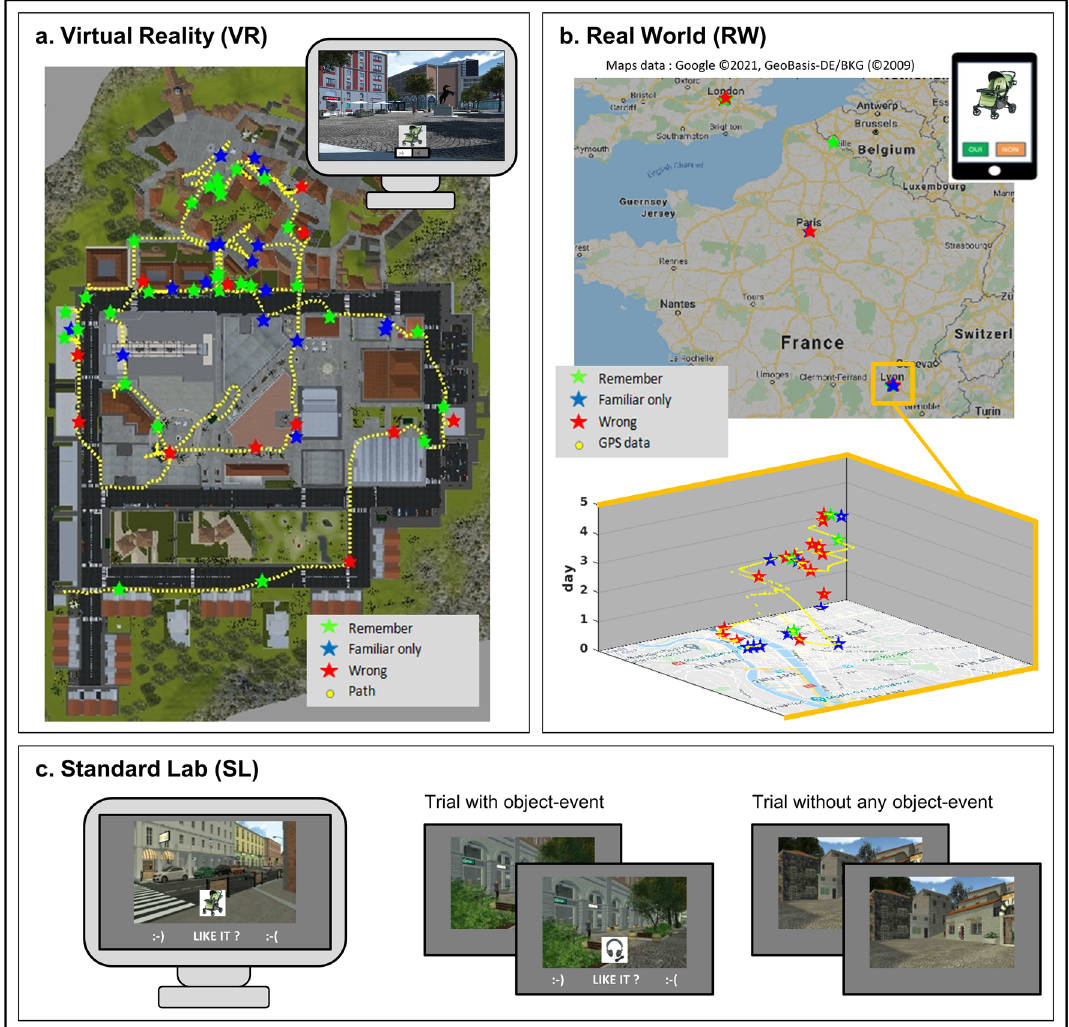
intervals, pictures of objects appeared in the bottom part of the screen and the participants performed a “like/ dislike” judgment (see inset, top-left). The main panel shows the path of one participant (yellow dotted-line) and the locations where the memory probes were presented (stars, with the different colors coding whether the object was subsequently retrieved as Remember , Familiar or wrongly categorized as a New object). ( b ) The real-world protocol (RW) entailed the encoding of the memory probes via a dedicated mobile-phone system, over a period of up to several weeks (see also Table 1). The participants received the object-images on the mobile-phone and responded with a “like/dislike” judgment. The position of the participant was geolocalised via the GPS functionality of the mobile-phone. The panel presents the data of one participant, who traveled in different cities and countries during the encoding phase. The bottom part of the panel shows a close-up view of the participant’s path in the area of Lyon during a 5 days period (see z-axis). ( c ) Illustration of the Standard Laboratory protocol (SL) that comprised a sequence of unrelated trials presented on the computer screen. Half of the trials included arbitrarily paired object- and place-images ("Trial with object-event"). The other half of the trials included only the place-images ("Trial without any object-event). When the trial included the object- image, the participant performed the “like/dislike” judgment. The place-images showed views of the virtual town (cf. a